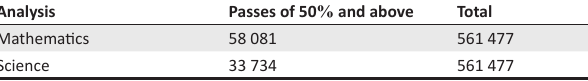
TABLE 2: Analysis of mathematics and science marks in 2008. Analysis